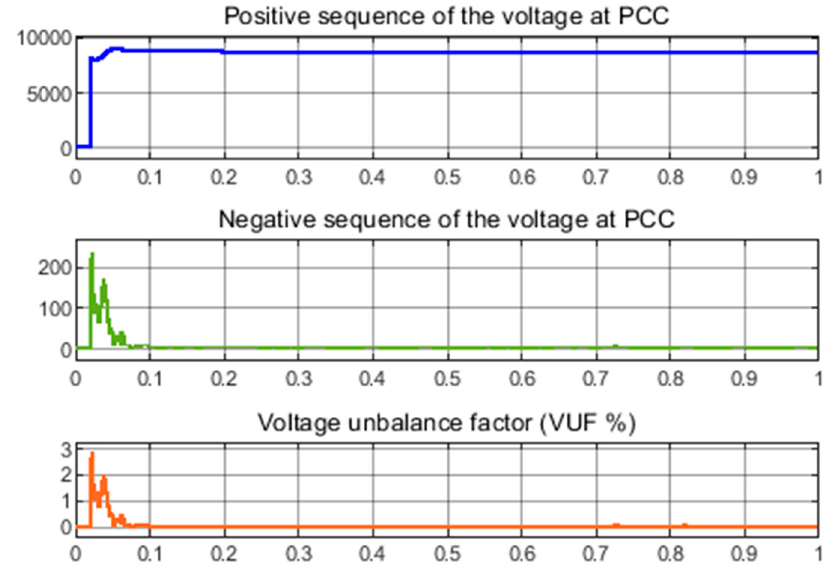
Figure 19. Voltage unbalance factor (VUF%) at the PCC.